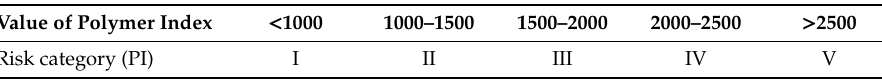
Table 4. Risk rating criteria for MP